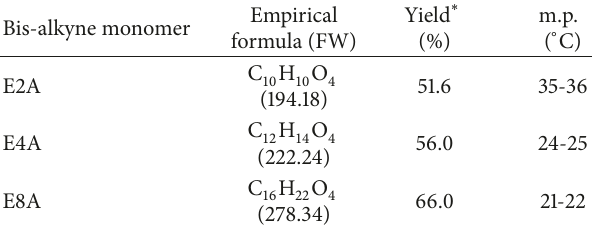
Table 1: The characteristics of bis-alkyne